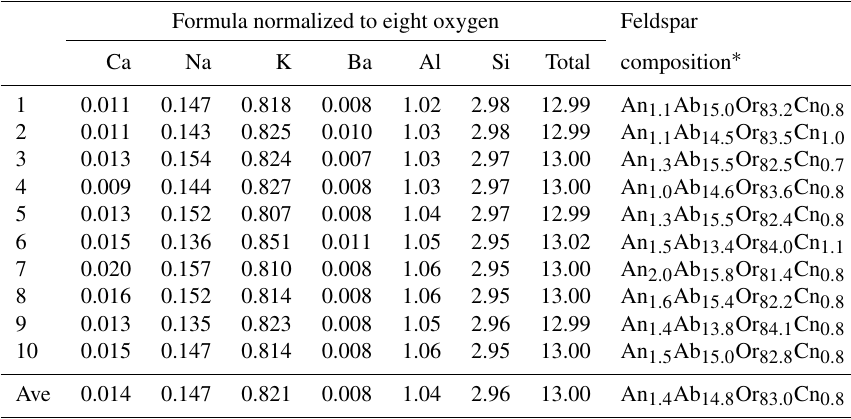
Table 1. Bulk composition of the RLS with major and minor elements from LA-ICP-MS analysis.